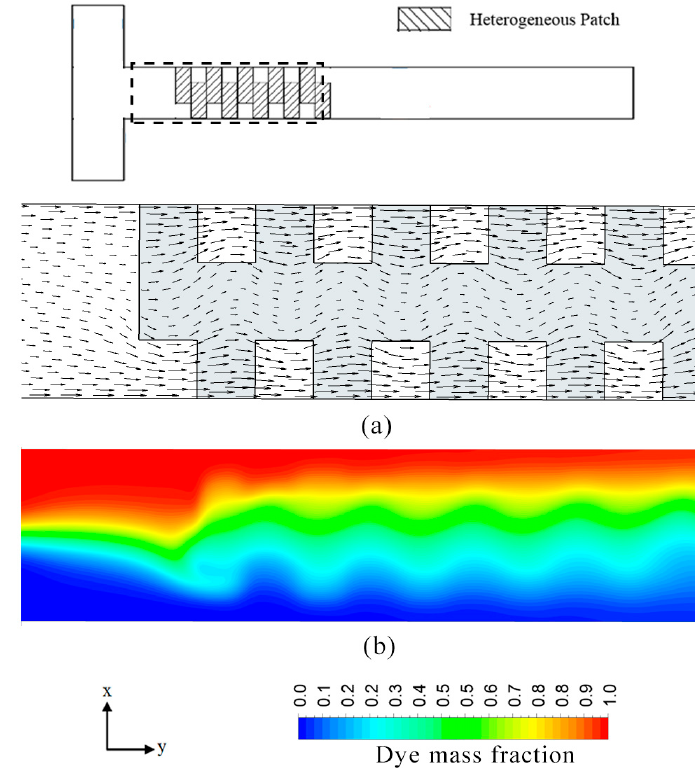
Figure 2. Mixing in the reference micromixer on x - y plane at E = 400 V/cm: ( a ) velocity vectors at z / H c = 0.33 and ( b ) dye mass fraction distribution at z / H c = 0.5.